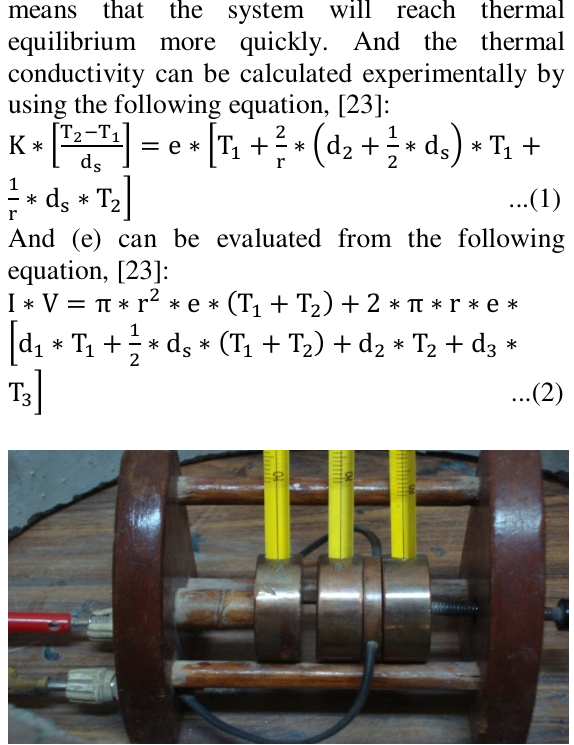
Fig. 9. Lee's disk apparatus .